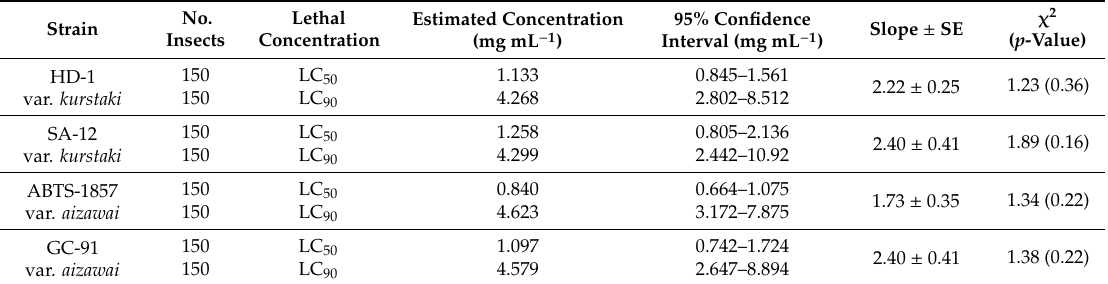
Table 1. Lethal concentration of Bacillus thuringiensis strains against Euprosterna elaeasa after 48 h exposure obtained from probit analysis (df = 5). The chi-square value refers to the goodness of fit test at p >